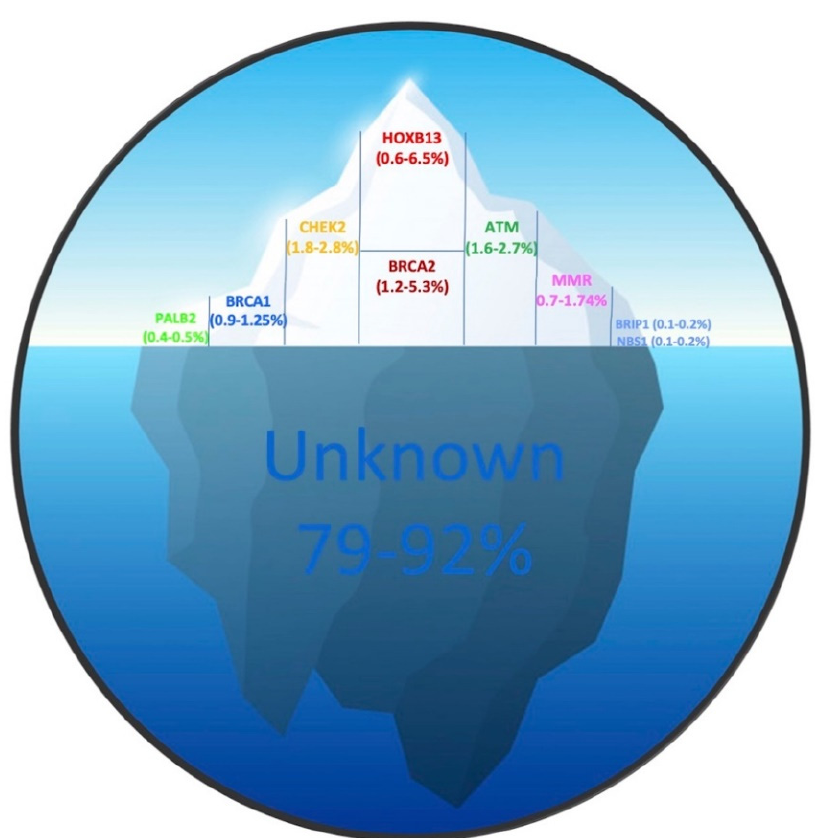
Figure 1. Frequency of mutations found in HPCa related genes. The proportion of PCa attributable to hereditary factors has been estimated to be 5–15%. The upper part of the iceberg constitutes 7.4–21% and indicates the gene mutation frequencies known so far, while the lower part, constituting 79–92%, represents the portion of genes not yet identified. Partner and localizer of BRCA2 ( PALB2 ); Breast cancer type1 ( BRCA1 ); Checkpoint kinase 2 ( CHEK2 ); Breast cancer type2 ( BRCA2 ); Homeobox B13 ( HOXB13 ); ATM serine/threonine kinase ( ATM ); Mismatch Repair (MMR); BRCA1 interacting protein C-terminal helicase 1 ( BRIP1 ); Nijmegen Breakage Syndrome 1 ( NBS1 ). To date, the genes more consistently associated to HPCa susceptibility have been re- ported by the National Comprehensive Cancer Network (NCCN) guidelines and include LS associated genes ( MLH1 , MSH2 , MSH6 , and PMS2 ) and homologous recombination genes ( BRCA1/2 , ATM , PALB2 , CHEK2 ) [22]. Additional genes, including the above